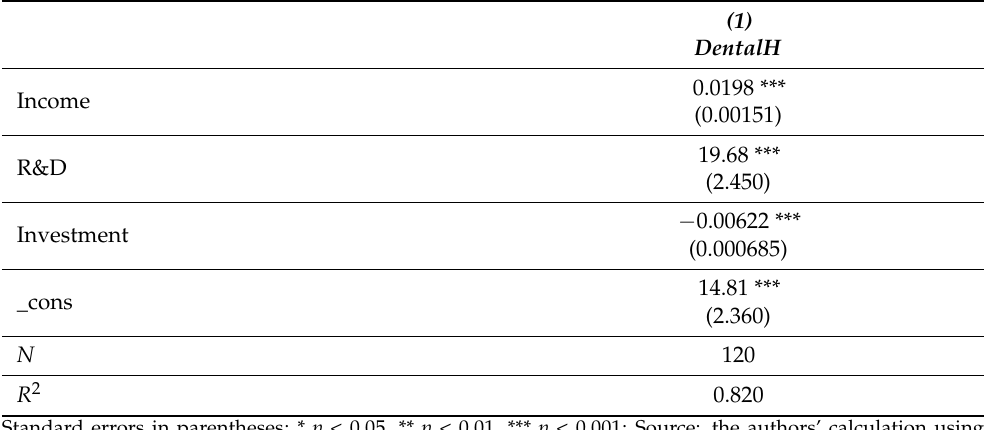
Table 4. The results of the regression